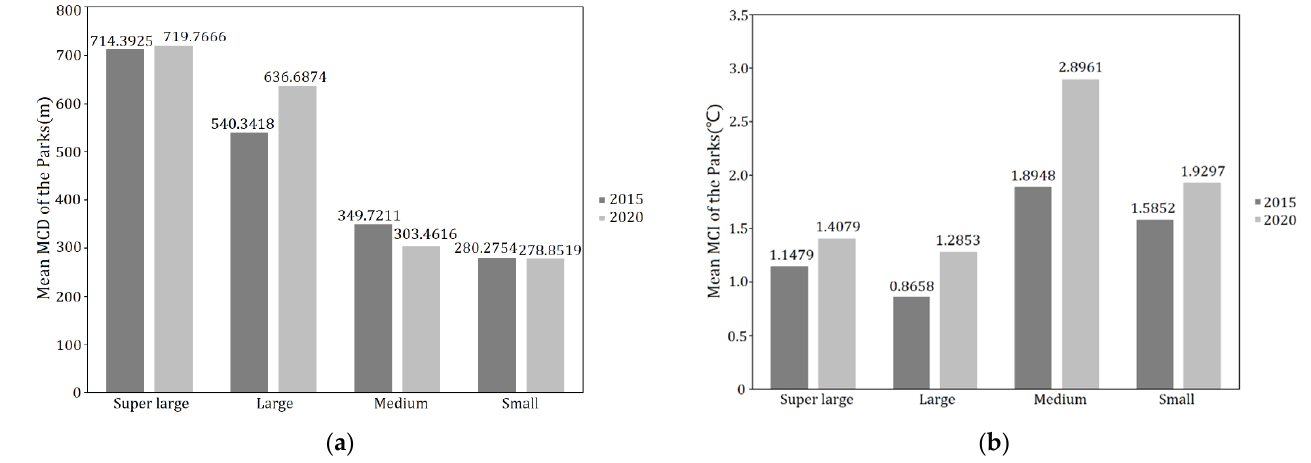
Figure 8. Mean MCD ( a ) and MCI ( b ) of different park groups in 2015 and 2020.